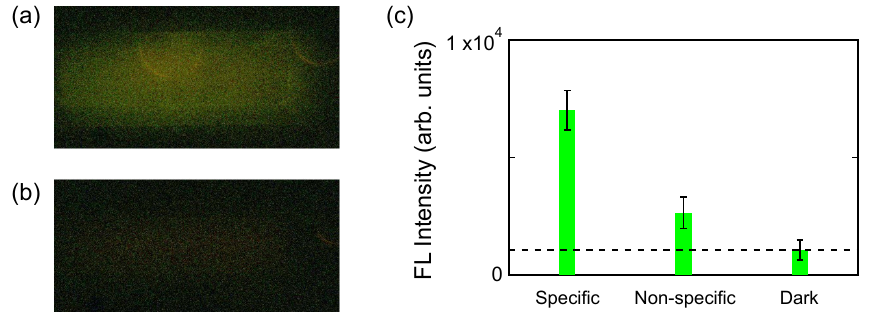
Figure 3. A test of specific detection. FL images of ( a ) specific target–probe pairs and ( b ) non-specific pairs. After the background was subtracted, these images were shown with increasing brightness by 40% and decreasing contrast by − 20%. ( c ) Quantitative comparison of FL intensities evaluated from the FL images ( a , b ). Dark-level signal is also shown, which originates from dark current on the charge-coupled device (CCD)